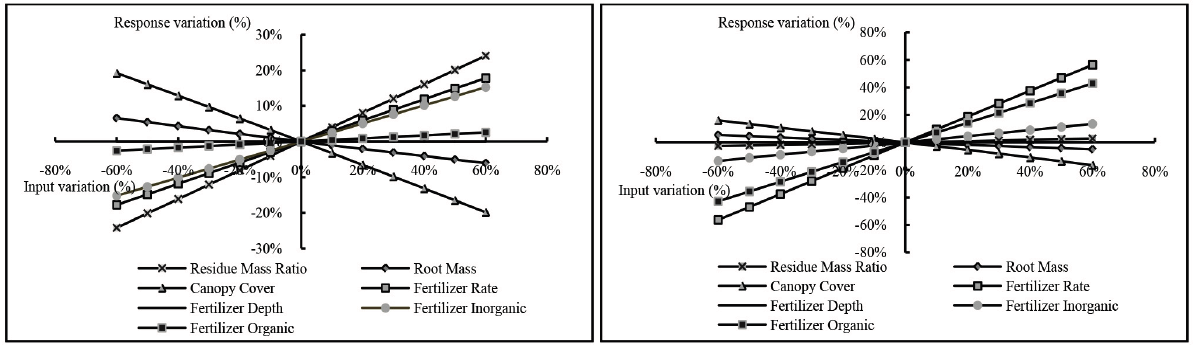
Figure 6. The sensitivity of nutrient for ( left ) TN and ( right ) TP to the selected input parameters